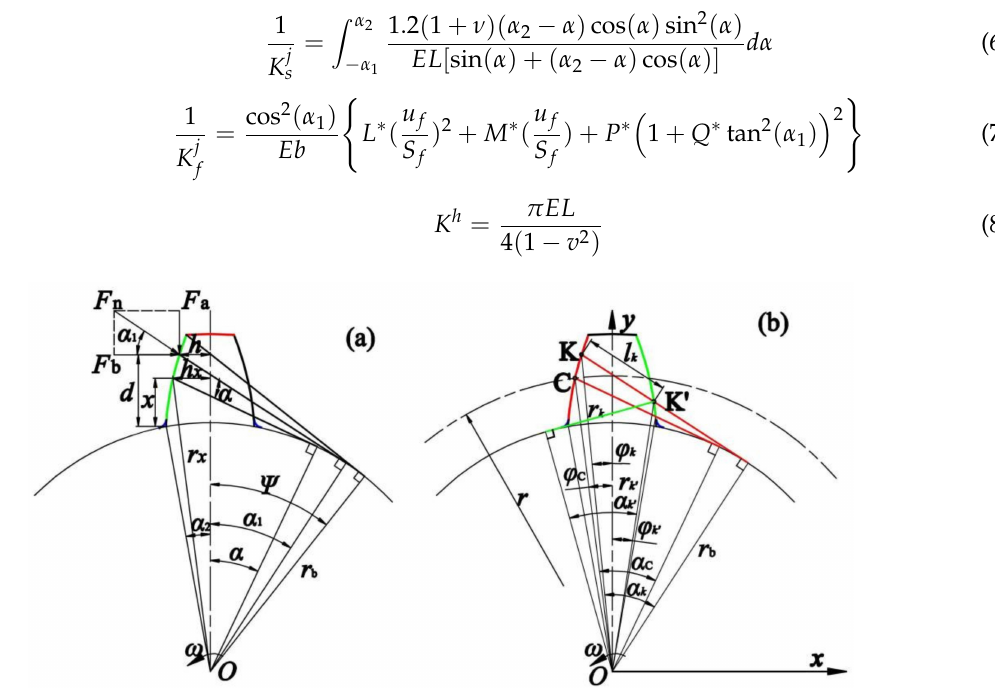
Figure 2. The gear tooth profile model. ( a ) Load on the tooth; ( b ) Geometric model of l k .